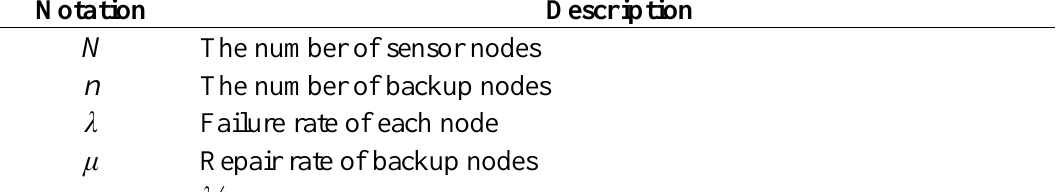
Table 1. List of notations used in this